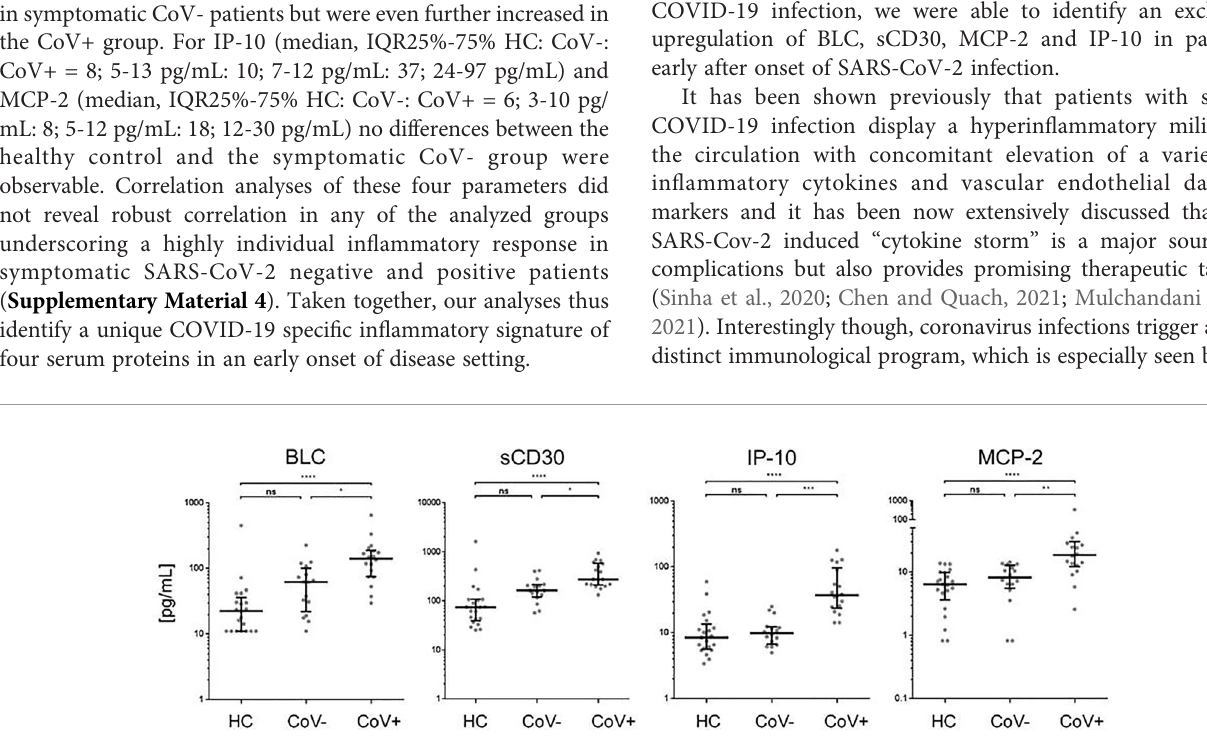
FIGURE 3 | Immune activation markers speci fi cally elevated in the serum of COVID-19+ patients compared to COVID- patients and healthy controls. The indicated in fl ammatory markers were assessed by multiplex analysis from the serum of healthy control (HC) volunteers, symptomatic, COVID-19 negative tested patients (CoV-) and symptomatic, COVID-19 positive tested patients (CoV+). For each marker, individual results are depicted as dot plots. Each point represents the median of two technical replicates of each individual. Data are shown on a logarithmic scale for better visualization. Data are shown as median and interquartile range 25%-75%. p > 0.05 = ns not signi fi cant; *p < 0.05, **p < 0.01, ***p < 0.001, ****p < 0.0001, Group differences between the three cohorts were tested using Kruskal-Wallis-test in conjunction with Dunn ’ s multiple comparisons test using multiplicity adjusted calculation of p-values. (HC, n=21), (CoV-, n=16), (CoV+, n=18); BLC, chemokine B lymphocyte chemoattractant; sCD30, soluble CD30; IP-10, interferon-gamma induced protein 10; MCP-2, monocyte chemotactic